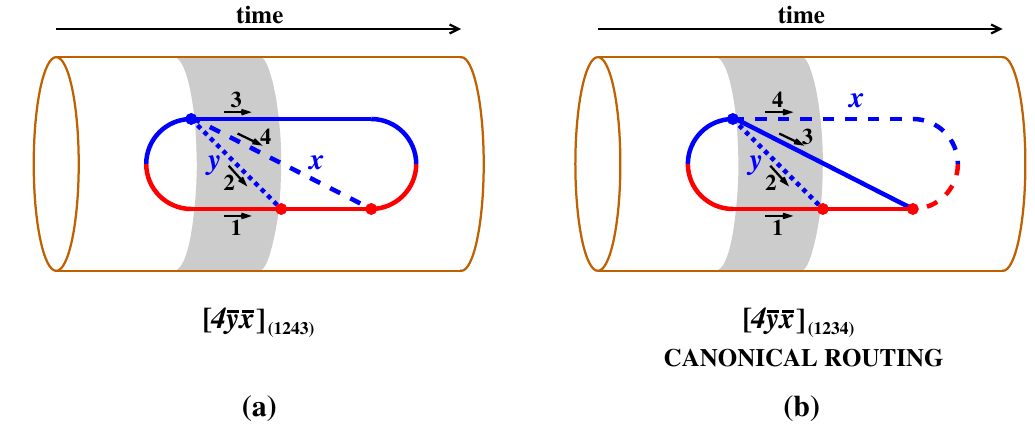
Figure 10 . The two large- N c color routings of the 4¯ y ¯ x diagram, drawn on a time-ordered cylinder. These particular diagrams are drawn completely on the front side of the cylinder. The shaded region shows the times where four particles are present in the interference diagram (three in the amplitude plus one in the conjugate amplitude). Numbering of the lines in that region is according to the convention